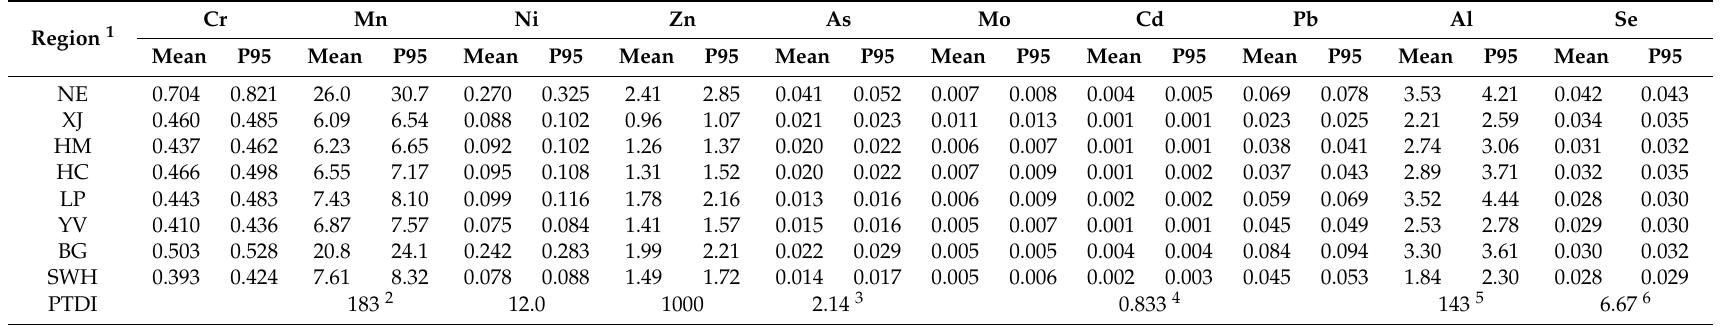
Table 3. Estimated daily intake (EDI, µ g/kg bw/day) of each element via consumption of wine from eight Chinese regions.